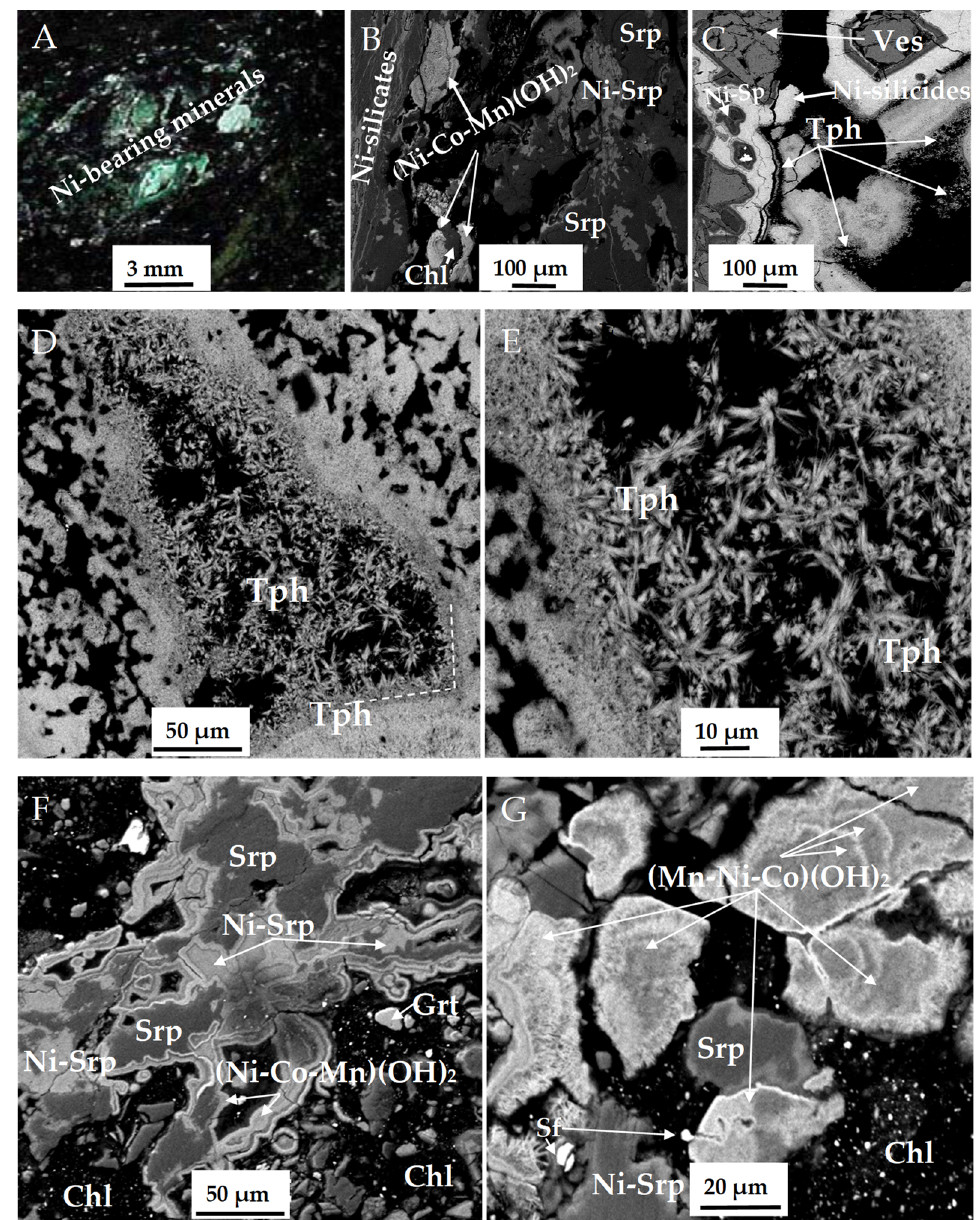
Figure 4. Photomicrograph ( A ) of the metamorphosed Fe ‐ Ni ‐ laterite ore from the area of Vermion Mt., showing a green association of theophrastite with (Co, Mn, Ni) ‐ hydroxides and Ni ‐ silicates. BSE images ( B–G ) showing textural relationship between Ni ‐ Si ‐ silicates and Ni ‐ silicides covering fragmented crystals of vesuvianite ( B ); (Co, Mn, Ni) ‐ solid solutions exhibiting concentrating development, whereas serpentine cross ‐ cut all previous formations ( C ); early stage of tiny theophrastite crystals exhibiting a special association with Ni ‐ silicides ( C,D ); close ‐ up image of theophrastite ( E ). Texture relationships between serpentine, Ni ‐ serpentine and (Ni ‐ Co ‐ Mn) ‐ hydroxides reflecting the potential sequence of their formation ( F,G ). Symbols: Tph = theophrastite; Ves = vesuvianite; Srp = serpentine; Chl = chlorite; Grt = garnet; Sf = sulfides. Photos taken from Economou ‐ Eliopoulos et al. [12].